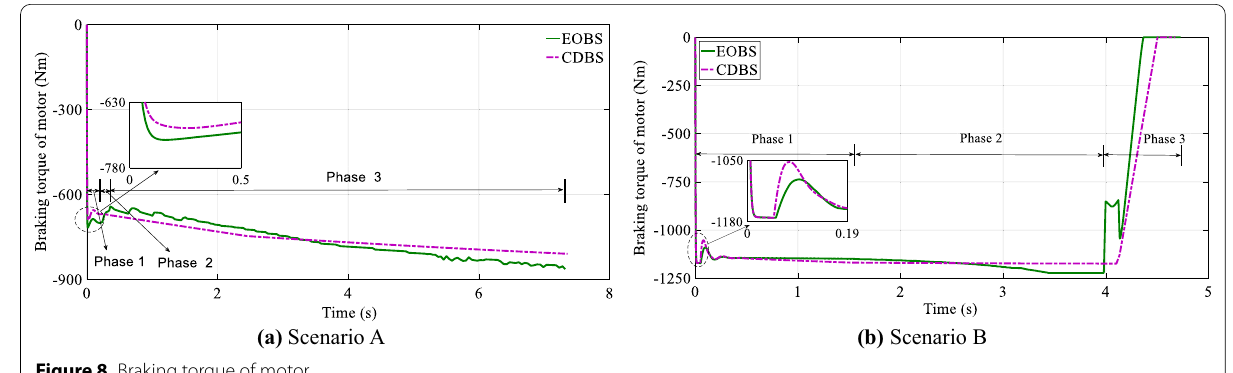
Figure 8 Braking torque of